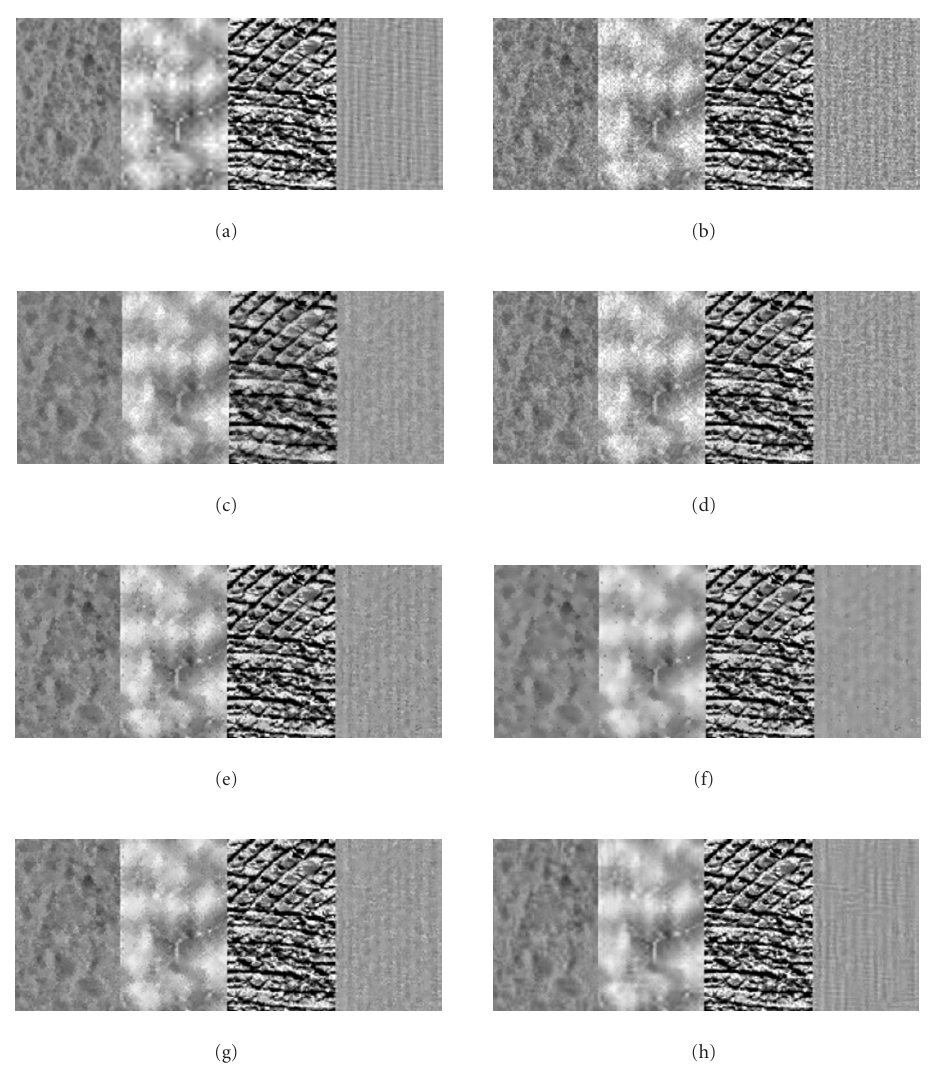
Figure 6: Visual representation of filtering results of four texture samples corrupted by (a) multiplicative noise σ 2 µ = 0 . 012, and (b) by di ff erent DPFs: (c) the 5 × 5 CWMF with the central element weight 11, (d) the FMHF, (e) the 5 × 5 sigma filter, (f) the 5 × 5 MSF, (g) the 5 × 5 local statistic Lee filter, and (h) the 8 × 8 DCT-based